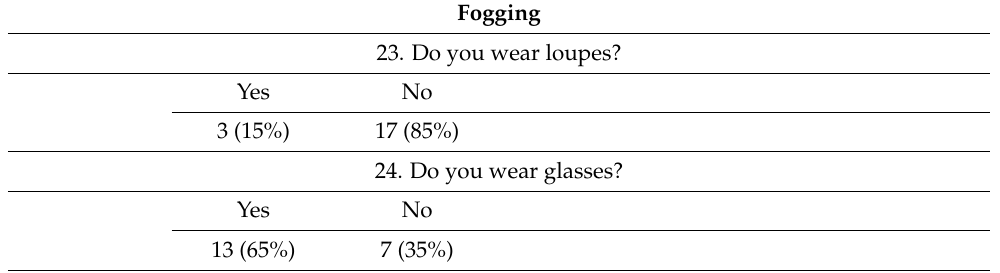
Fogging 23. Do you wear